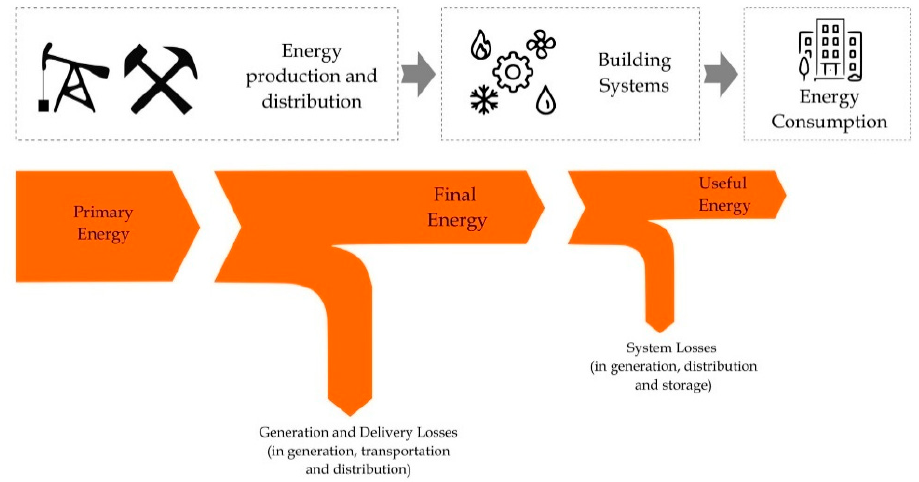
Figure 1. Scheme of the transformation of primary energy into useful energy.